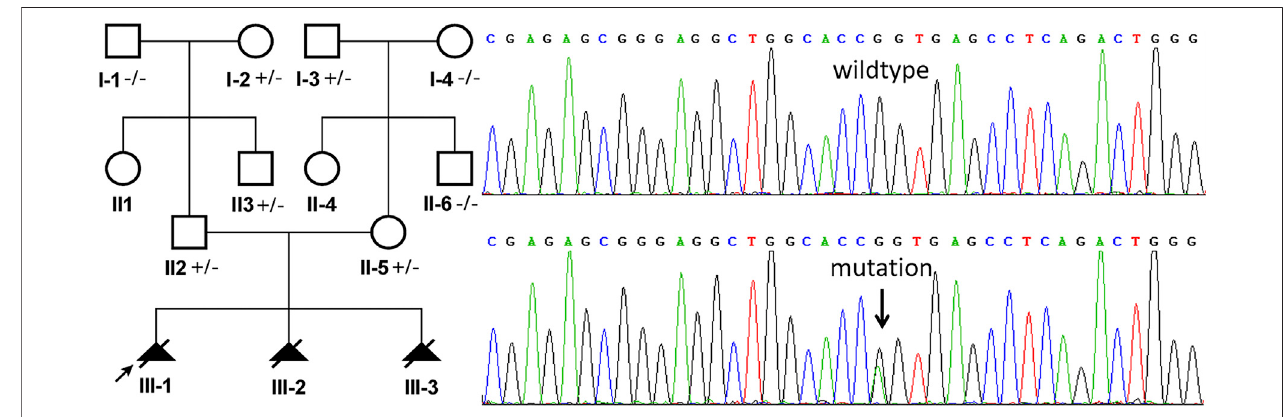
FIGURE2| SangersequencinganalysisofgenomicDNAfromfamilymembers.Thegenotypesof BBS1 werec.1339G > AheterozygousinII:2(husband,Maternal Origin) and II:5 (wife, Paternal Origin). The mutation is indicated by the